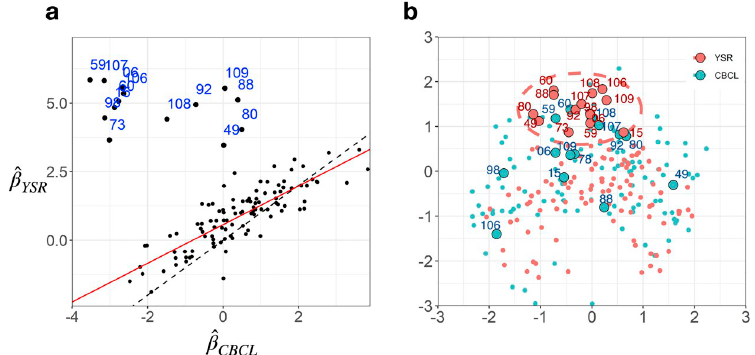
Fig 2. Item-wise comparison between the CBCL and YSR. (a) Comparison between the CBCL and YSR item coefficients ^ b is displayed. The red line is the linear regression line between the CBCL and YSR estimates. The dotted i line is y = x . Numbers indicate the outliers that deviate largely from the linear trend. For most test items, the two sets of ^ b are similar with the correlation of r = 0.83. However, the indicated items do not follow this general pattern. (b) An i integrated interaction map for the CBCL and YSR item positions is presented. Blue and red dots represent the item positions identified in the CBCL and YSR data, respectively. Larger dots with number labels are the outlier items identified in (a). Note that the distance between dots indicates the degree of association of the two items in the latent space. For the close items, if respondents respond positively to an item, they are more likely to respond positively to the other item.